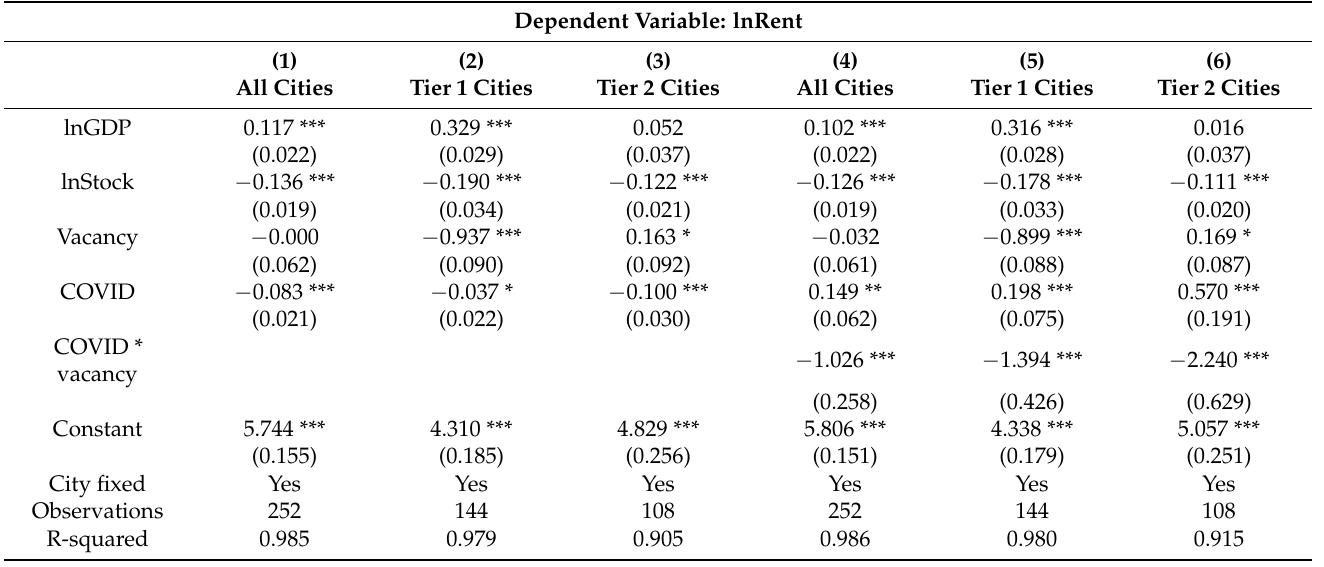
Table 4. The Results of Office Rent Long-term